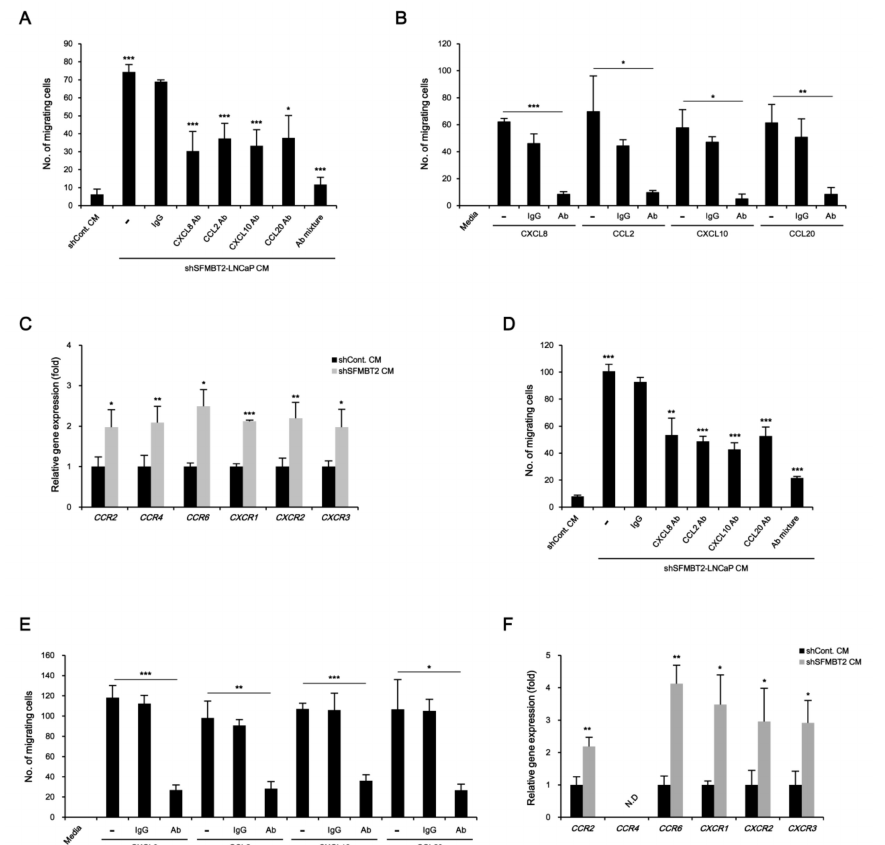
Figure 3. Chemokine-mediated migration of preadipocytes and TAMs. ( A ) Culture media (CM) from LNCaP cells stably transfected with SFMBT2 shRNA promote the migration of 3T3-L1 preadipocytes. However, the addition of antibodies against CXCL8, CCL2, CXCL10, and CCL20, and a mixture of antibodies reduces the migration of 3T3-L1 preadipocytes. After incubation of 3T3-L1 preadipocytes with antibodies against indicated chemokines in culture media from LNCaP cells stably transfected with SFMBT2 (shSFMBT2) or control shRNA (shCont), transwell assay was performed. Migrating 3T3-L1 preadipocytes were counted. ( B ) Treatment of CXCL8, CCL2, CXCL10, and CCL20 promotes the migration of 3T3-L1 preadipocytes. The addition of antibodies against CXCL8, CCL2, CXCL10, and CCL20 reduces the migration of 3T3-L1 preadipocytes. After incubation of 3T3-L1